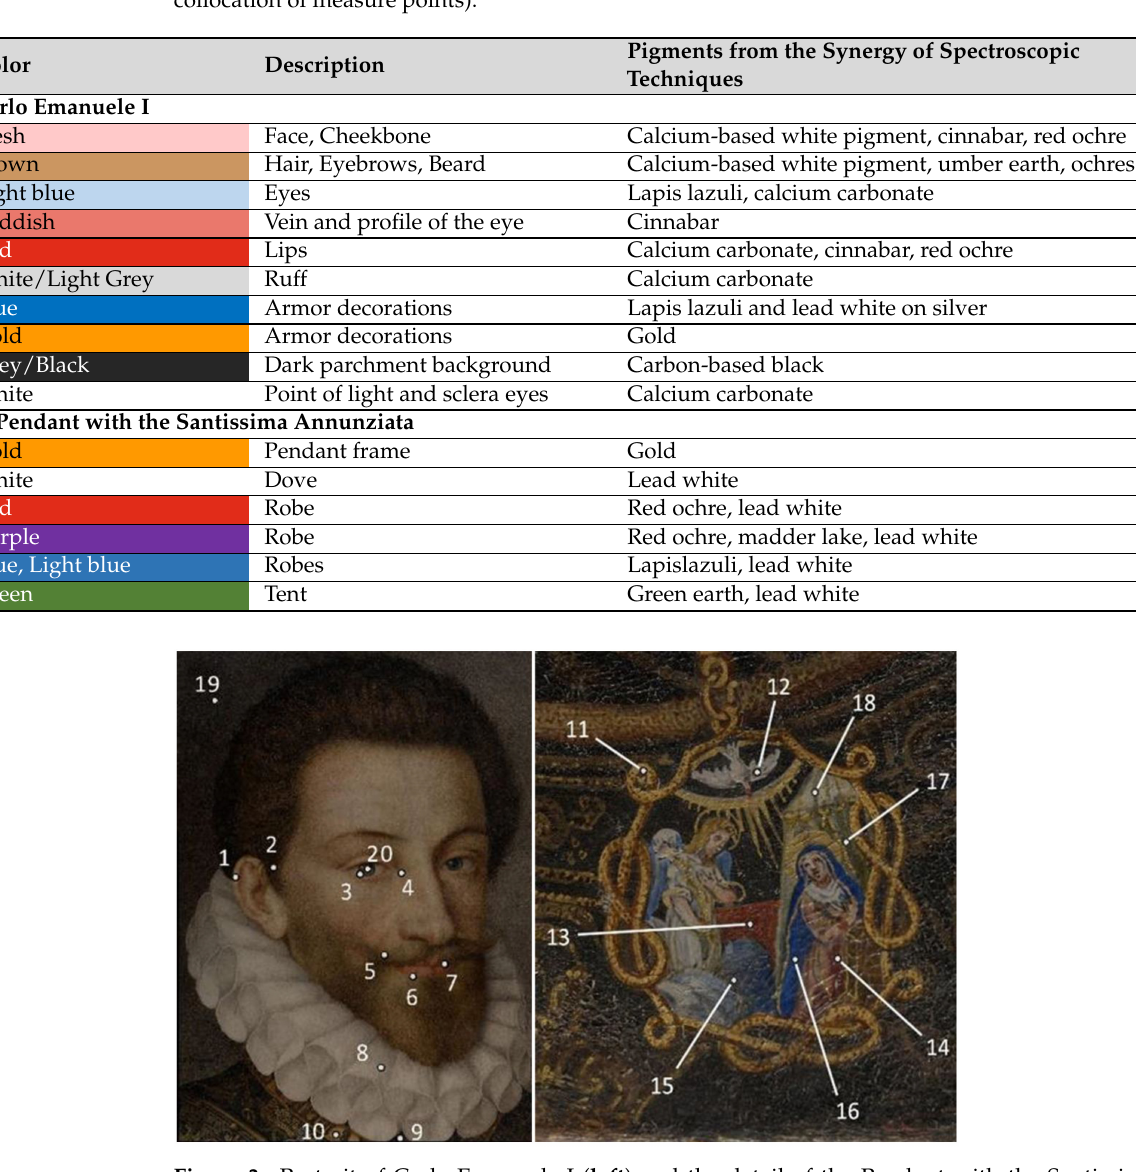
Figure 3. Portrait of Carlo Emanuele I ( left ) and the detail of the Pendant with the Santissima Annunziata ( right ), with the collocation of the measure